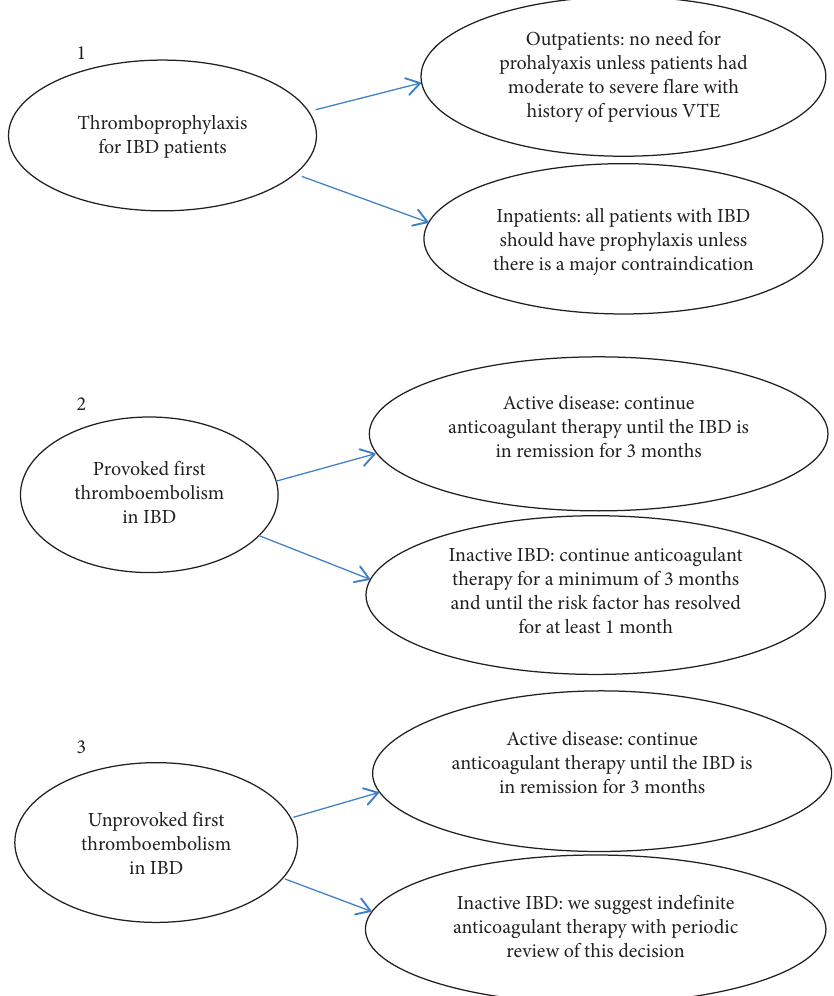
Figure 5: Summary of recommendations of the Canadian Association of Gastroenterology